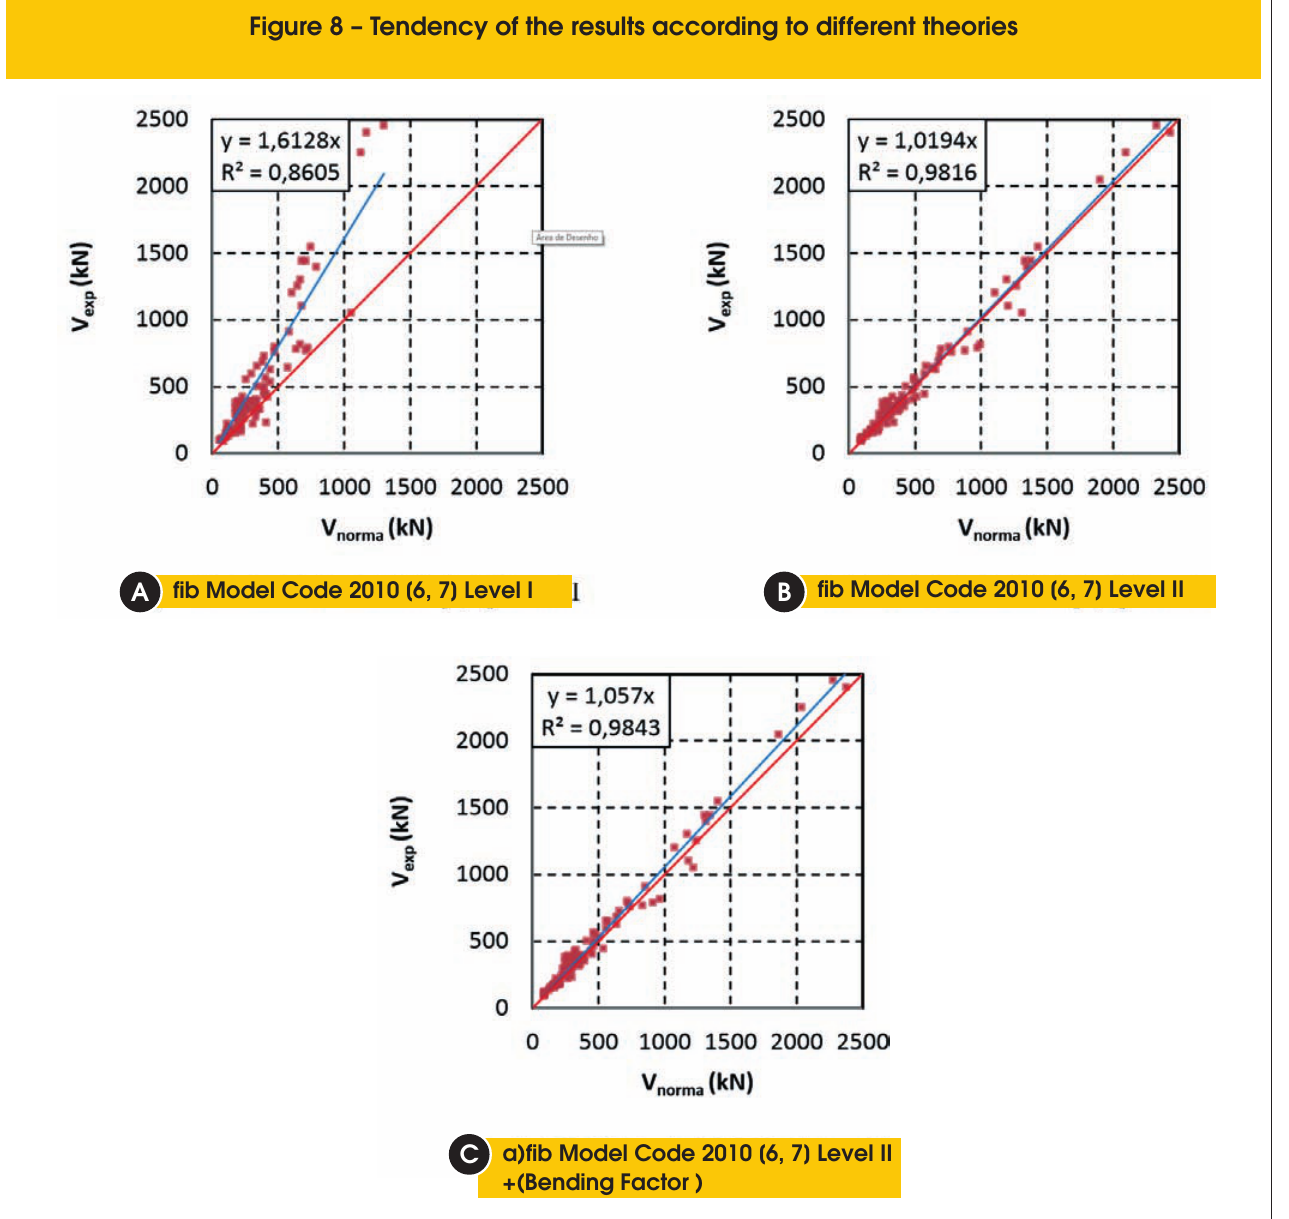
Figure 8 – Tendency of the results according to different